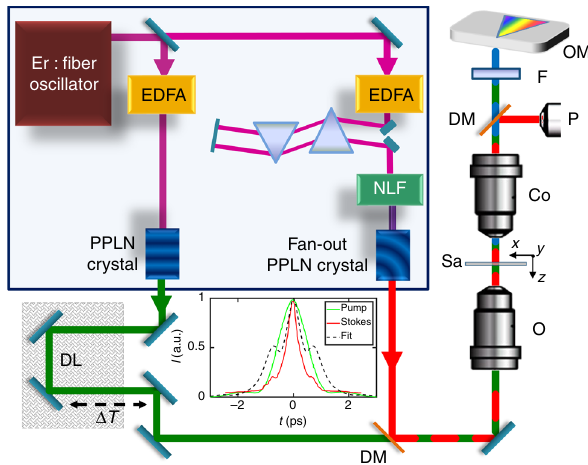
Fig. 2 FWM setup. EDFA erbium-doped fi ber ampli fi ed, NLF nonlinear fi ber for SC generation, DL delay line, DM dichroic mirror, O objective, Sa sample, Co condenser, P powermeter, F fi lter, OMA optical multichannel analyzer. Purple, green, and red lines represent the beam pathways of 1550 nm, 784 nm (PP), and tunable SP, respectively. The second-harmonic autocorrelation of PP (green line) and SP (red line) are reported in the inset. The black dashed line simulates the autocorrelation obtained by using the pro fi le from the fi t (colored dashed lines) in Fig.